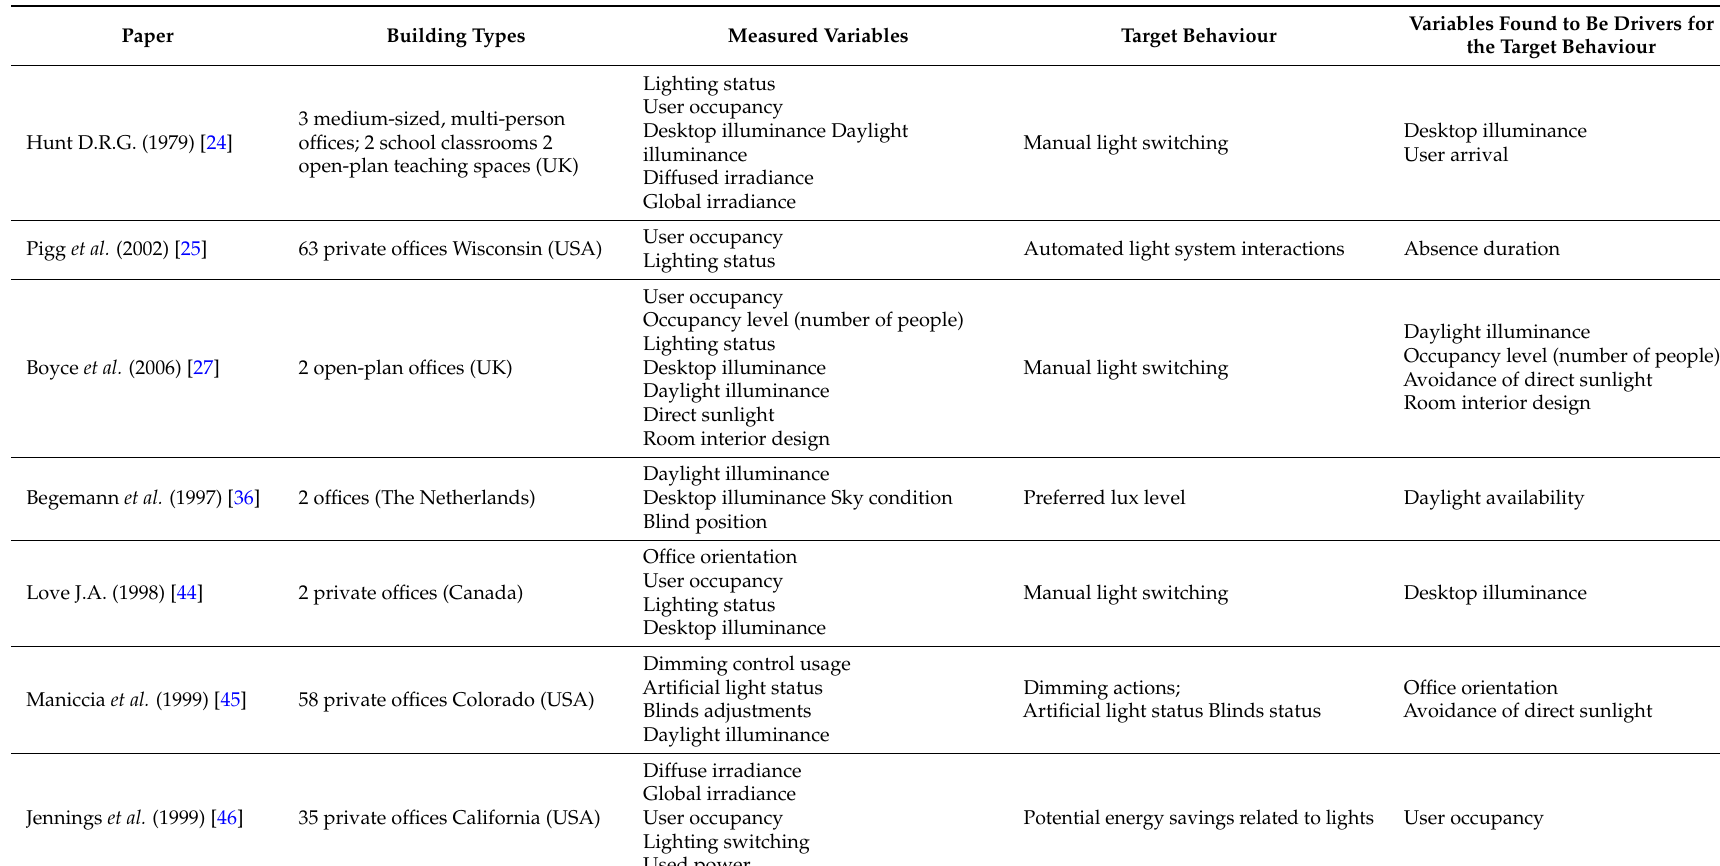
Table 1. Total number of actions over the ceiling lighting